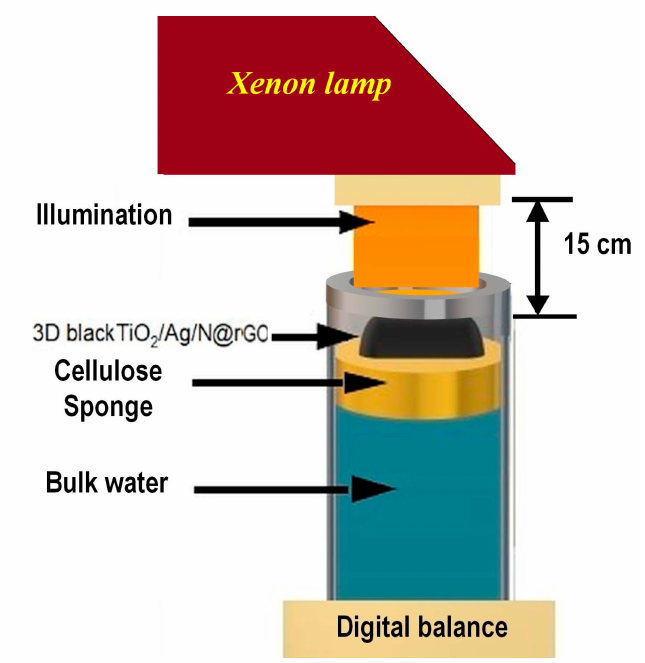
Figure 2. Schematic showing the solar-driven interfacial desalination